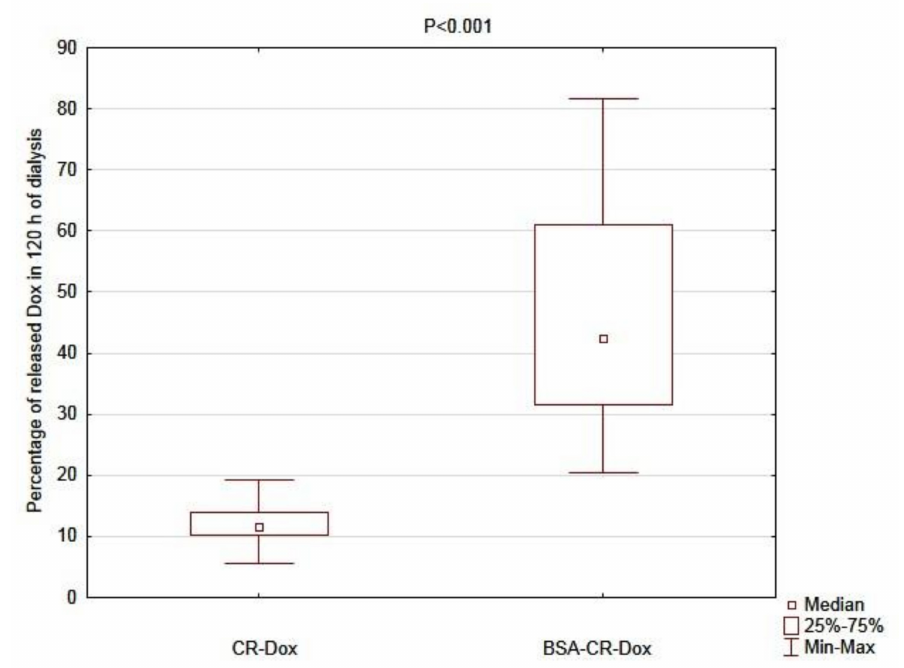
Figure 7. The comparison of the percentage of released Dox at 120 h of three averaged dialy- sis experiments between double (CR–Dox, n = 18, median = 11.52 [IQR: 10.28–13.9]) and triple (BSA–CR–Dox, n = 18, median = 42.42 [IQR: 31.65–60.91]; n—number of probes, IQR—interquartile range)